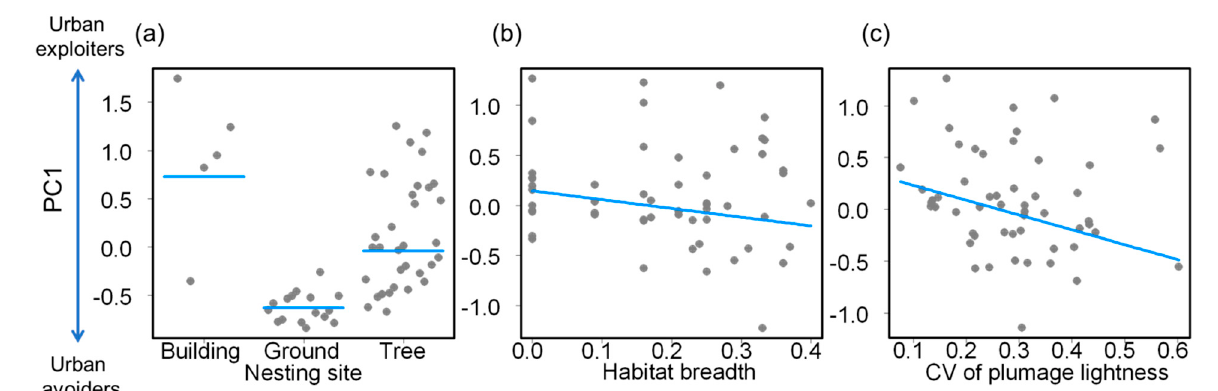
Figure 2. Relationship between the first principal component score values (PC1) of bird species and ( a ) nesting site, ( b ) habitat breadth, and ( c ) the intraspecific coefficient of variation (CV) of plumage lightness. Positive PC1 score values are related to urban exploiters, whereas negative values are related to urban avoiders. In ( a ) lines indicate mean values, whereas in ( b , c ) the lines indicate the fit of the phylogenetic generalized least square model.